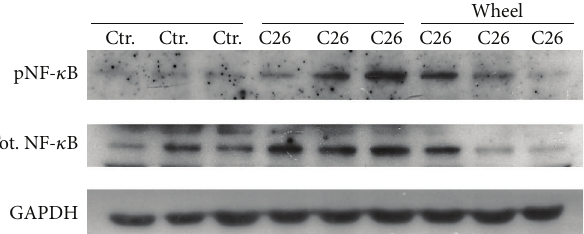
Figure 5: Exercise effects on NF-kB. WB of pNF-kB and total NF- kB of muscle extracts from mice treated as indicated. Each group of samples was loaded as triplicate of independent experiments. GAPDH was used as a loading control.